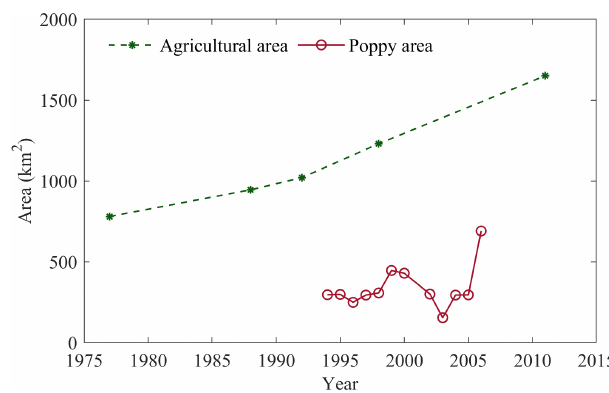
Figure 2. Evolution of total agricultural area in the HRB (1976– 2011) and poppy-cultivated area thereof